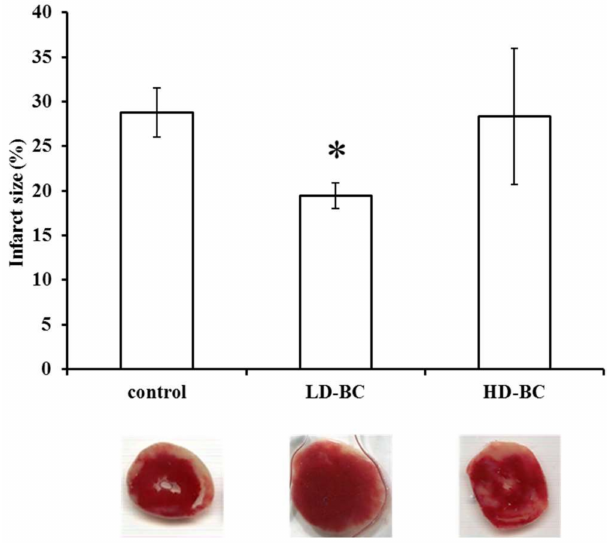
Figure 2. The effect of BC on infarcted zone magnitude. IS was measured in hearts ( n = 4) following 120 min of reperfused (REP) by perfusion with triphenyl-tetrazolium-chloride (TTC) solution, followed by macroscopic analysis of transverse sections of each heart. The average size (%) of the infarcted area ± SEM are shown for each group. * p < 0.05 in comparison with the values for hearts from vehicle-treated control animals. Representative pictures are also shown under the